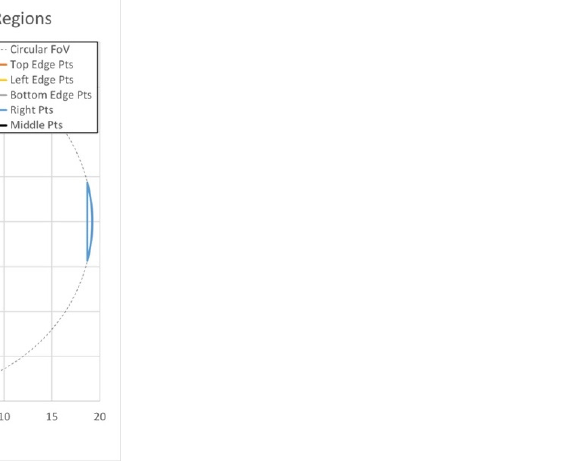
Figure 11. Five regions in the circular field of view of the Mid-40 lidar sensor used for analysis.